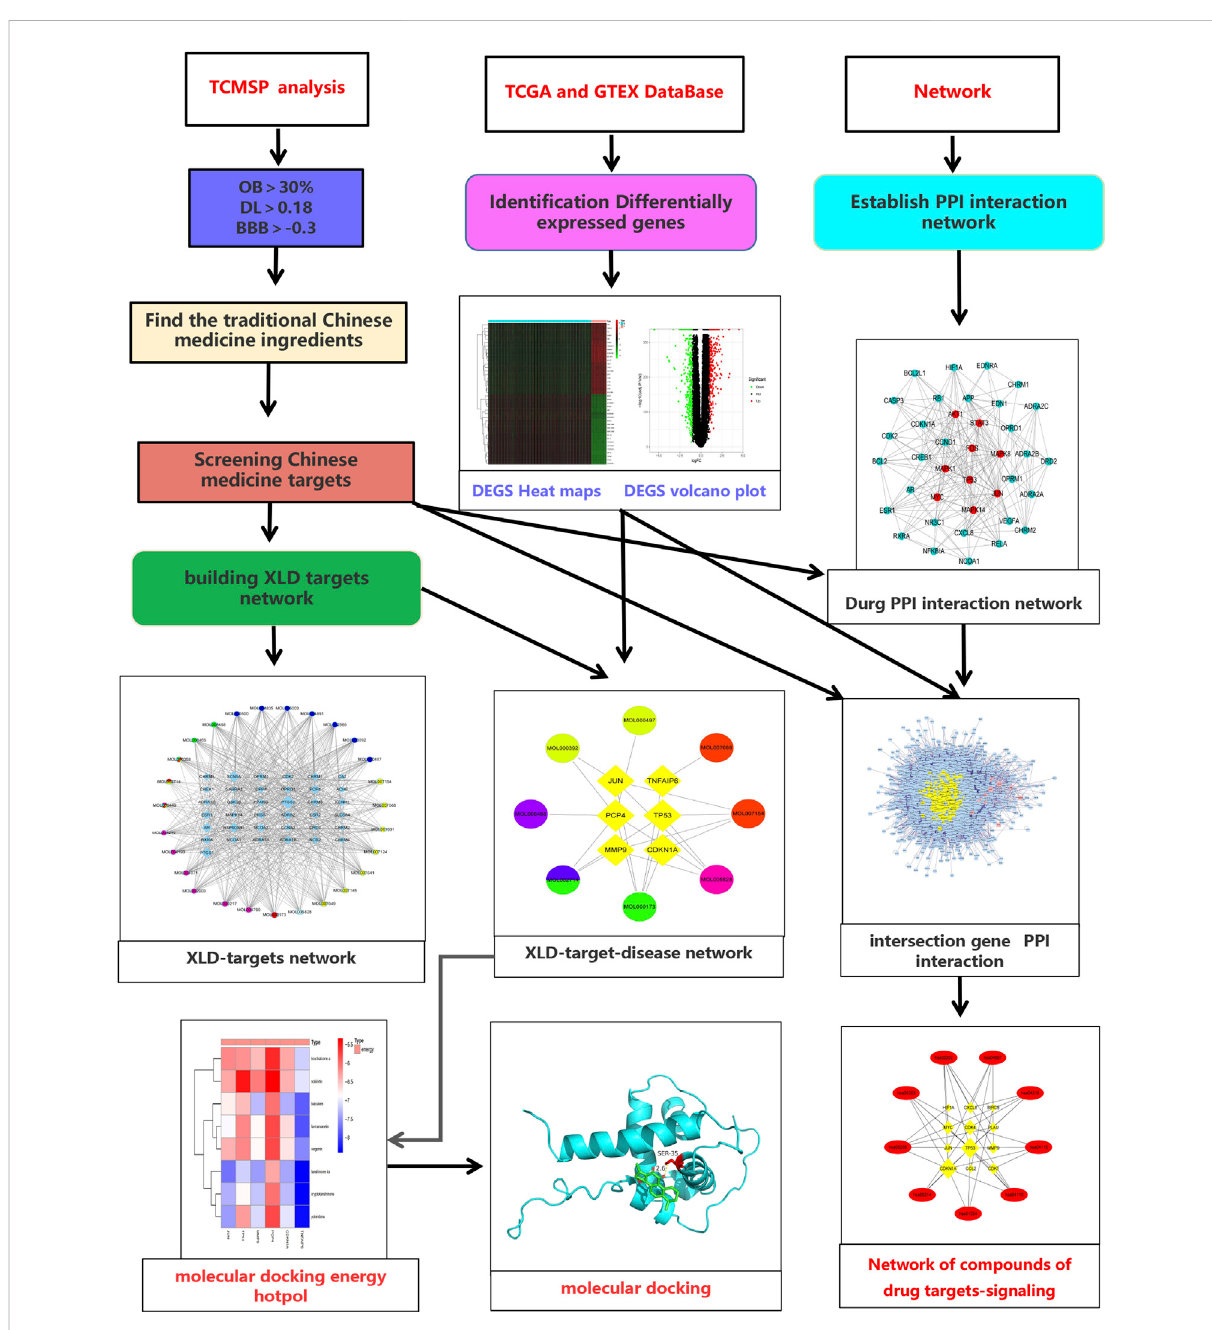
FIGURE 1 Flow chart of the systematic analysis of XLD for glioblastoma multiforme treatment. TCMSP, Traditional Chinese Medicine Systems PharmacologyDatabaseandAnalysisPlatform;OB,oralbioavailability;DL,drug-likeness;BBB,blood-brainbarrier;TCGA,Thecancergenomeatlas; GTEX, The Genotype-Tissue Expression; PPI, protein-protein interaction; XLD, Xiaoliu